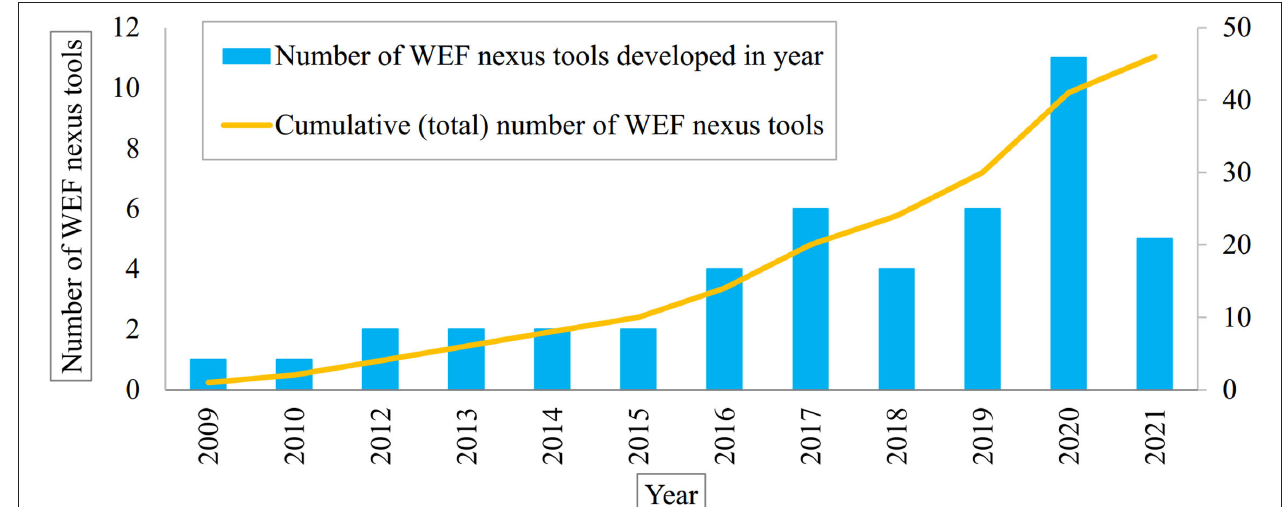
FIGURE 2 | Trend in the development of WEF nexus